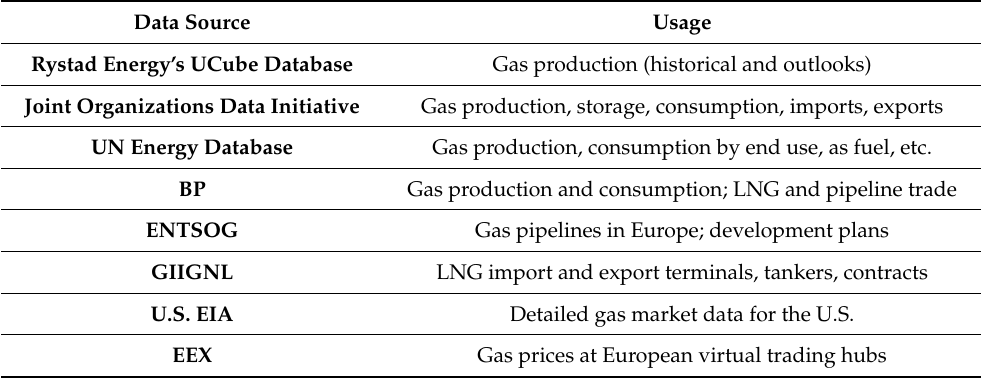
Table 1. Primary data sources for G2M2 ® base case